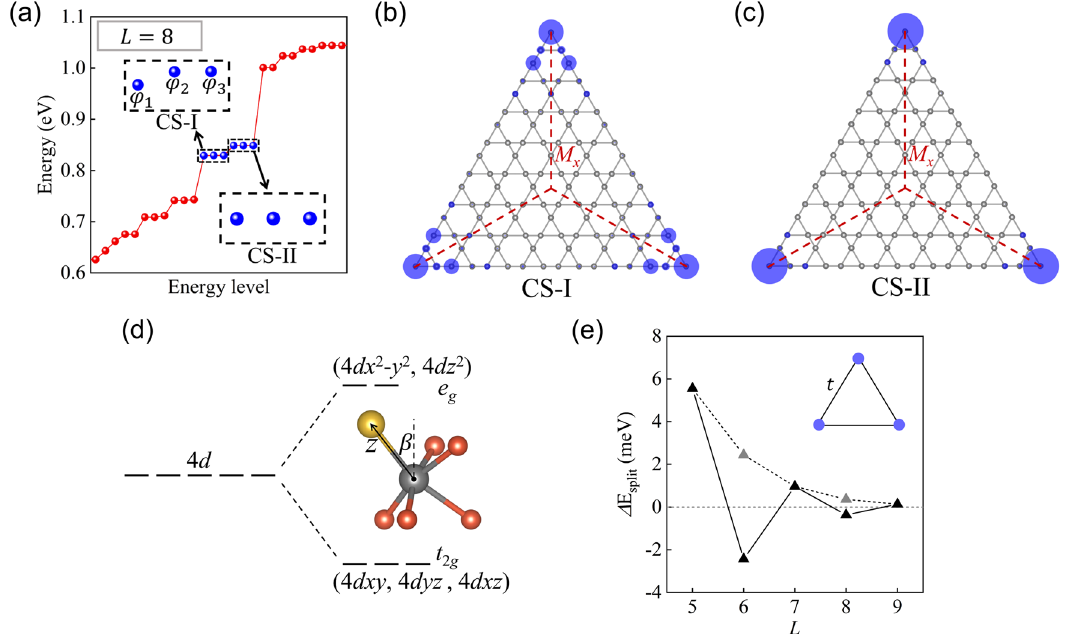
Fig. 4 Corner states of ML Nb 3 TeCl 7 . a Energy spectrum of the triangular nanodisk of Con fi guration 1 ( L ¼ 8 ) of ML Nb 3 TeCl 7 . Energy levels are plotted in ascending order. Two sets of corner states are indicated by blue solid circles. The inset: enlarged drawing of CS-I and CS-II. The three corner states of CS-I are labeled as φ 1 , φ 2 and φ 3 , respectively. b , c The calculated local density of states of CS-I and CS-II, respectively. The three equivalent mirrors M x are indicated by red dashed lines. d Schematic drawing of crystal fi eld splitting of Nb 4 d orbitals in NbTeCl 5 octahedron. The inset shows the NbTeCl 5 octahedron. The angle between rotated (Nb-Te direction) and previous (out of plane direction) z - direction is β . e The solid (dotted) line shows the energy splitting Δ E split (absolute value of Δ E split ) as a function of nanodisk size L . The inset shows the effective model to interpret the fi nite-size effect. The inter-corner effective hopping is t